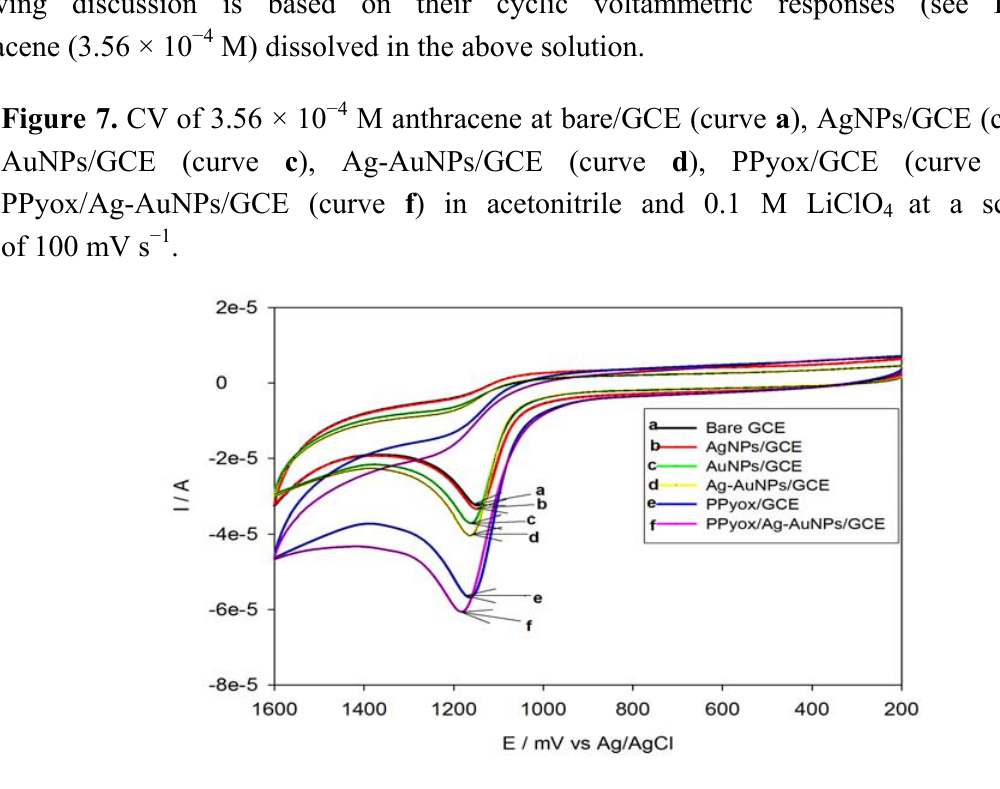
at a scan rate 4